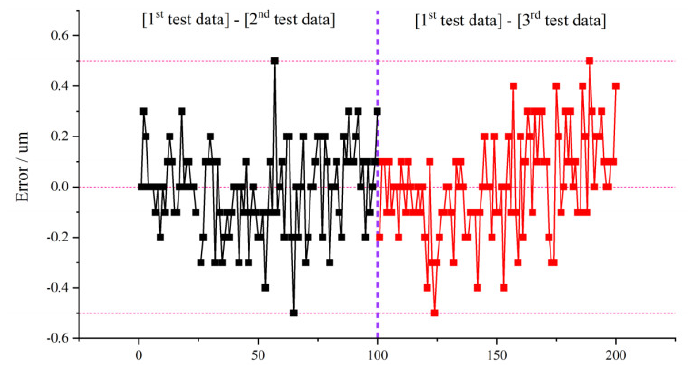
Figure 18. Repeated measurement error of different blades.